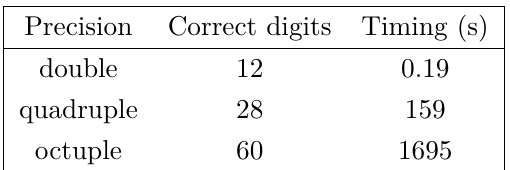
Figure 3. Distribution of logarithmic relative error of the one-mass pentagon functions (see eq. (5.5)) sampled on 10 5 kinematical points from a typical physical phase space (solid orange line). The cumulative distribution is displayed by the dashed line. The average evaluation time of all one-mass pentagon functions in double precision on a single thread is estimated in a run where kinematical points are evaluated in parallel on a server with Intel(R) Xeon(R) Silver 4216 CPU @ 2.10GHz .